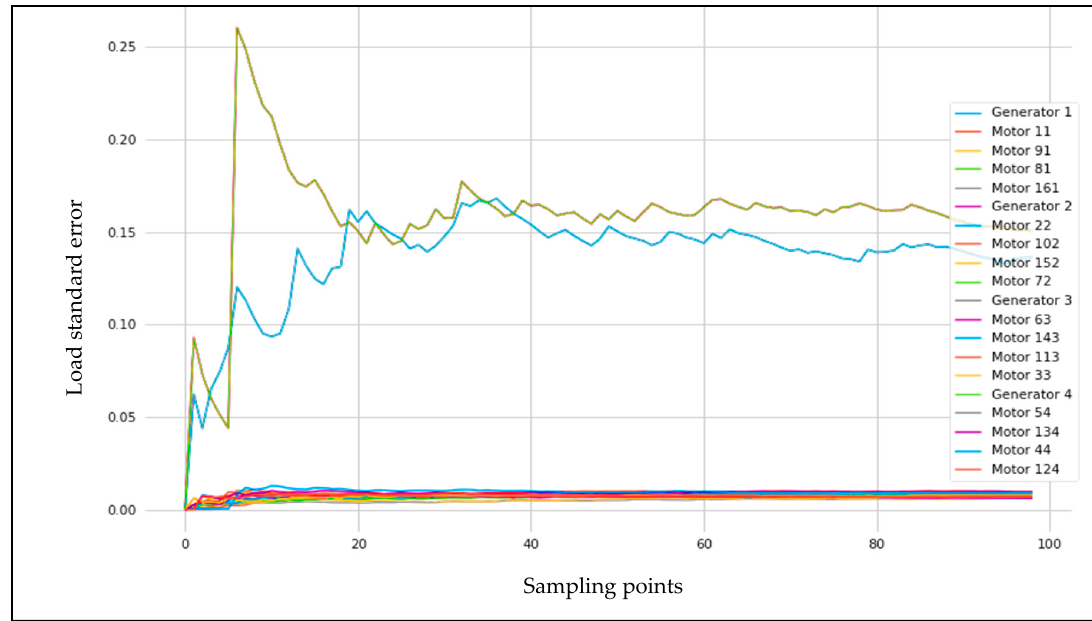
Figure 20. Monte Carlo standard deviation for the RTO study.